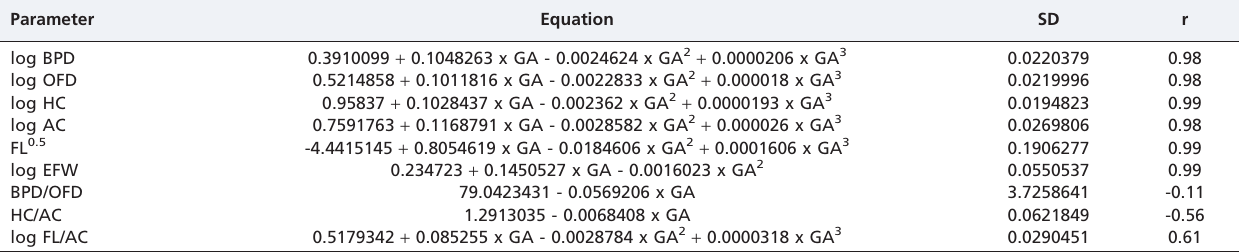
Table 1 - Polynomial regression formulas for ultrasound fetal biometry parameters according to gestational age in 125 uncomplicated, twin pregnancies. Parameter Equation